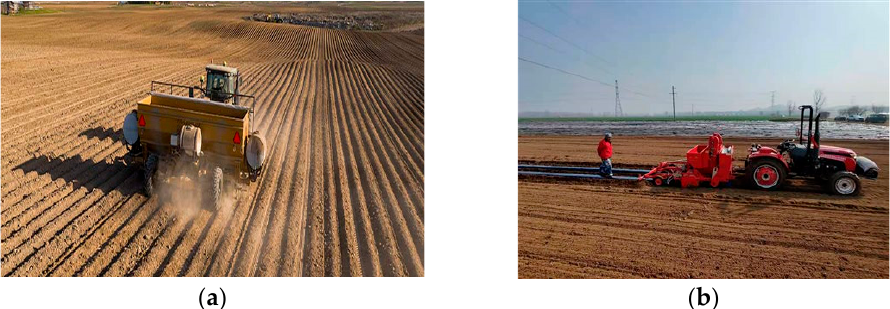
Figure 32. Automatic Potato planter with GPS system. ( a ) Double L planter works under GPS navigation. Reprinted with permission from ref. [12]. Copyright 2021 Double L Industries. ( b ) Navigation test of planter.